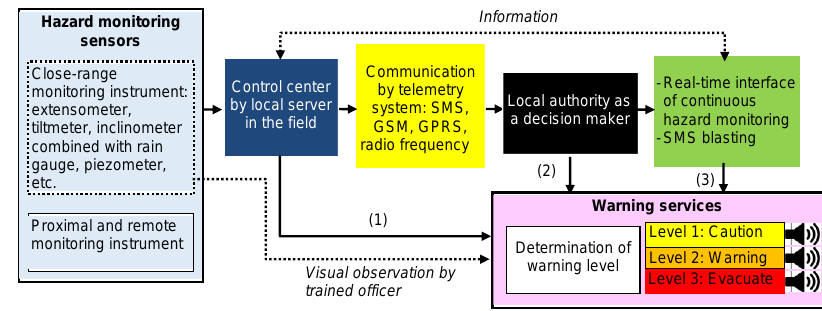
Figure 2: Mechanism of data transmission among landslide monitoring and warning devices. 15 Figure 2. Mechanism of data transmission among landslide monitoring and warning